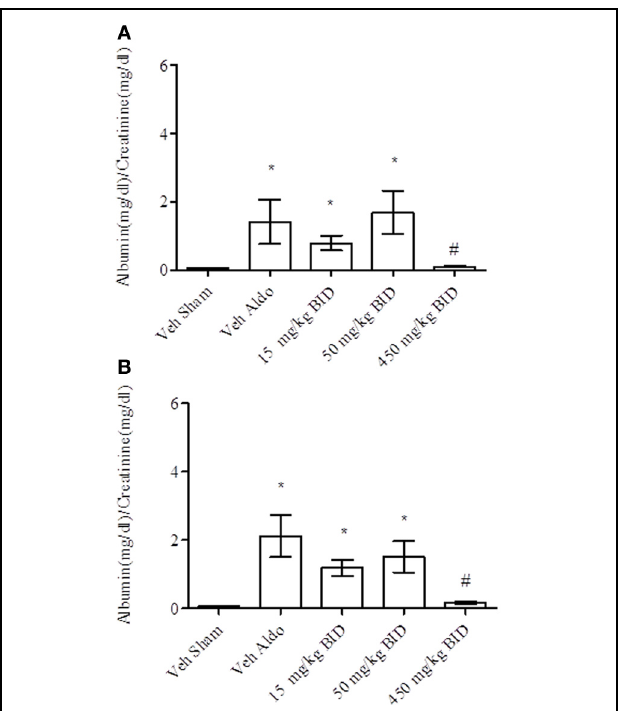
FIGURE 1 | Effect of eplerenone on UACR on day 14 (A) and day 26 (B). Data are represented as mean ± standard error of the mean. See Materials and Methods for statistical analysis. ∗ Indicates a significant difference from the vehicle sham (Veh Sham) group; # Indicates a significant difference from the vehicle + aldosterone (Veh Aldo)